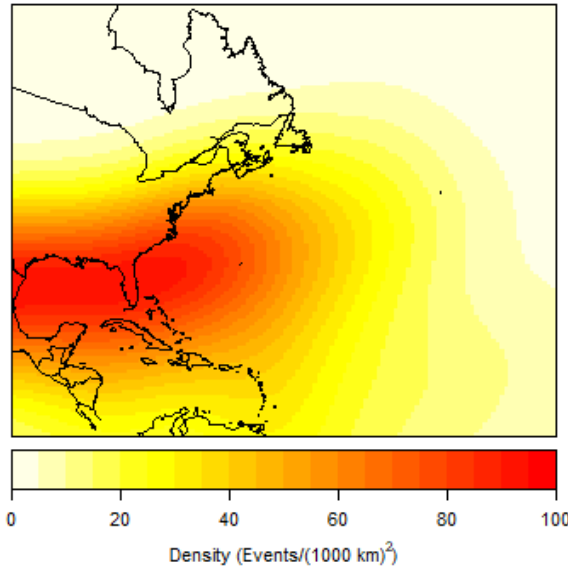
Figure 16. Kernel density analysis of non-RI hurricanes at their LMI points (1851 – 2017).